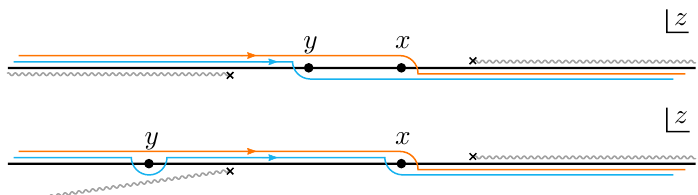
Figure 4 . The = R notation represents the average between the two contours, shown in orange and blue